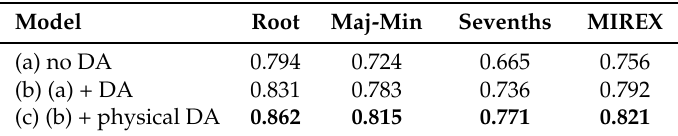
Table 5. WCSR Scores of the Compared Methods. The best Values are Represented in Bold. (DA Represents Data